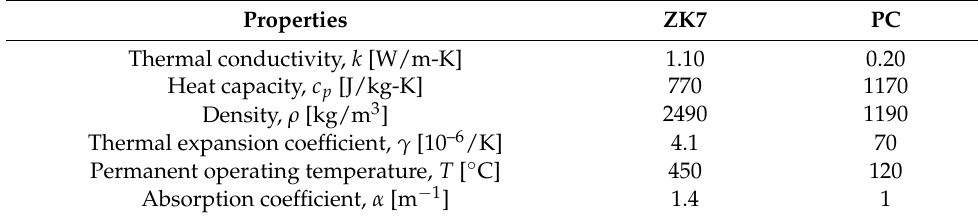
Table 1. Thermophysical property of waveguide materials [21,43]. 286